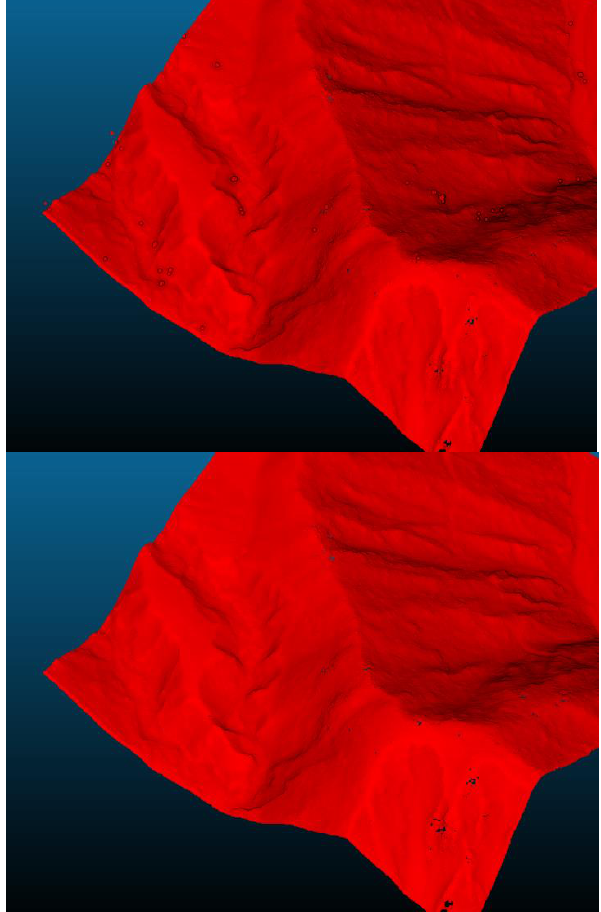
Figure 6. Resulting ground surface of baseline method (above) and process with pre-processing